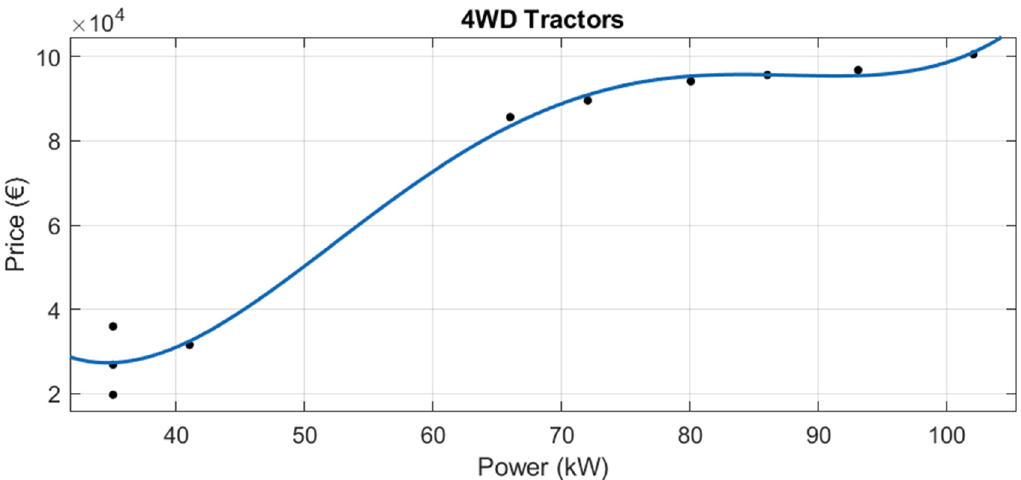
Figure 19. Price vs. power for 2WD narrow new tractors.